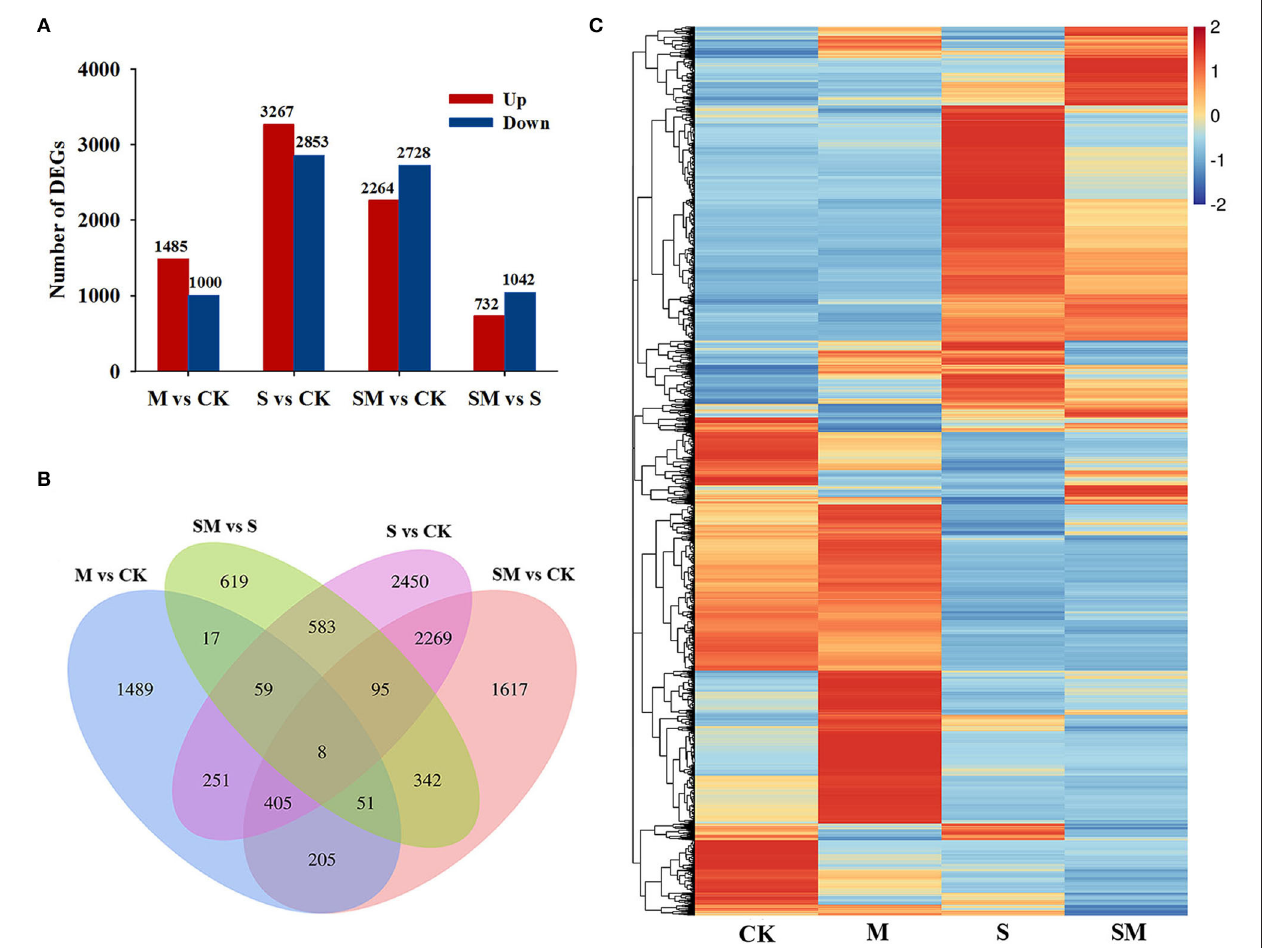
FIGURE 4 | Transcriptional profiles of alfalfa seedlings under different treatments. (A) Numbers of differentially expressed genes (DEGs) in the transcriptome data. (B) Venn diagram showing numbers of overlapping DEGs in the transcriptome data. (C) Hierarchical clustering (HCL) analysis of the DEGs under different treatments.